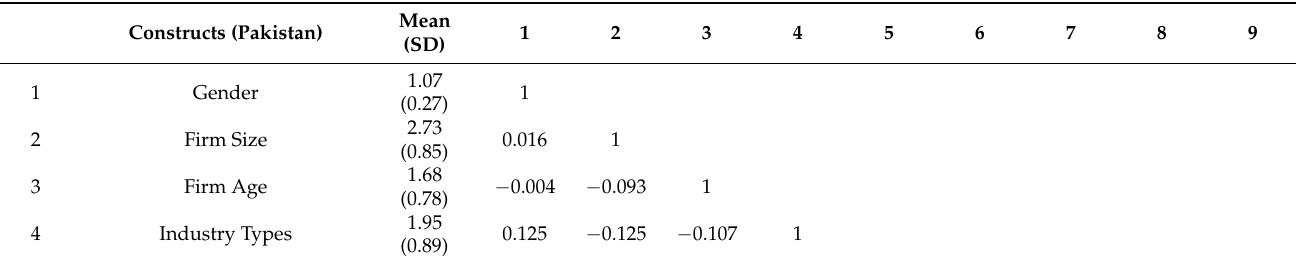
Table 5. Mean, standard deviation and